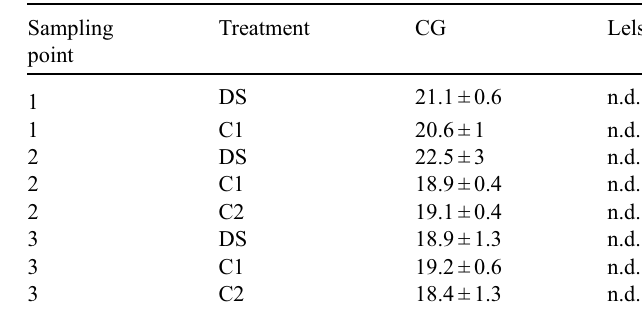
Table 1. Number of qPCR quanti fi cation cycles obtained from sample DNA using the general (CG) and endophyte speci fi c (Lels) primer pair (Average ±standard deviation, N =30). Treatments: DS= direct seeded line, C1 =collector 1, C2 =collector 2. n.d.= not